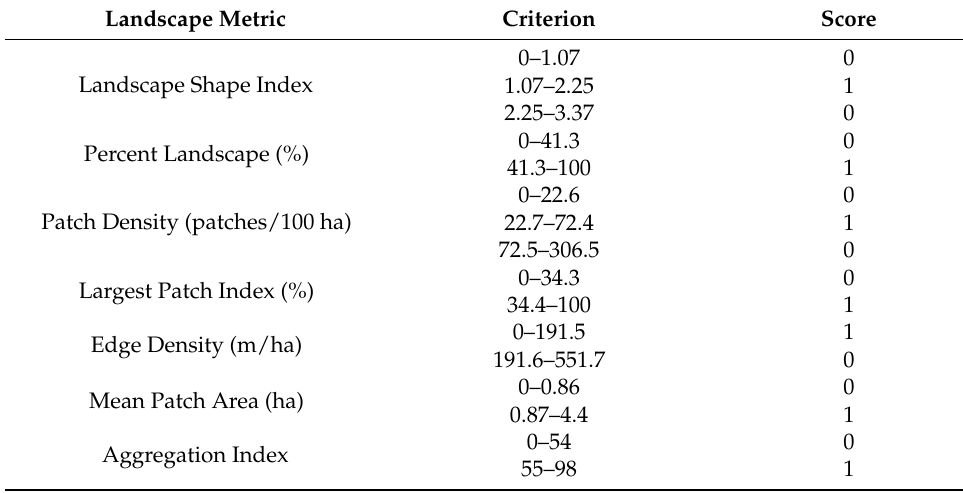
Table 2. Summary statistics for defining the optimal range of woody cover conditions for ocelots in southern Texas. Values were derived from moving window analysis and GPS relocations for ocelots. The criterion of suitability scores was representative of the 90% range of values (1) and the bottom 5%, and the top 5% were excluded from analysis